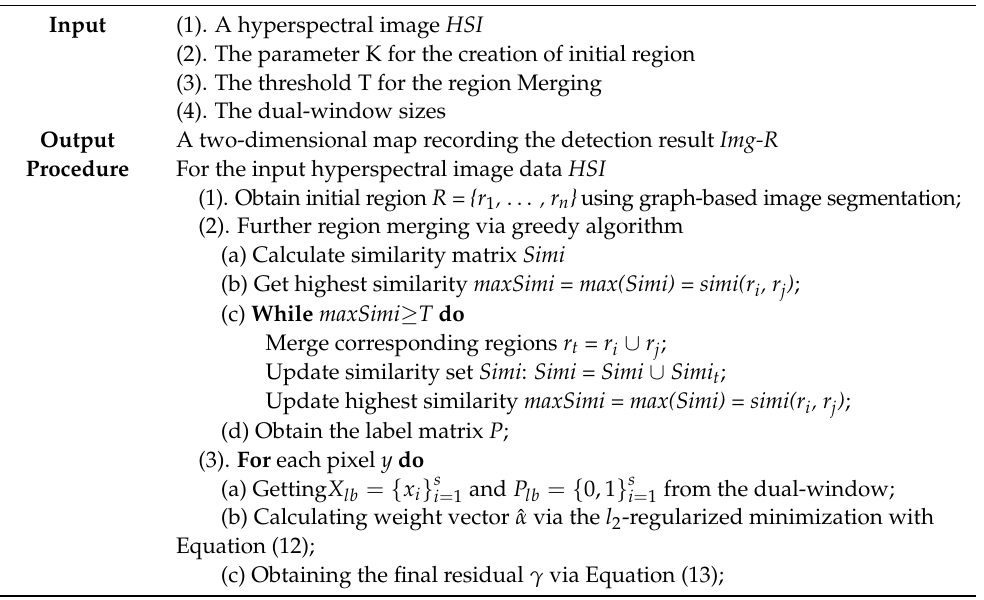
Algorithm 1: Selective Search Collaborative Representation Anomaly